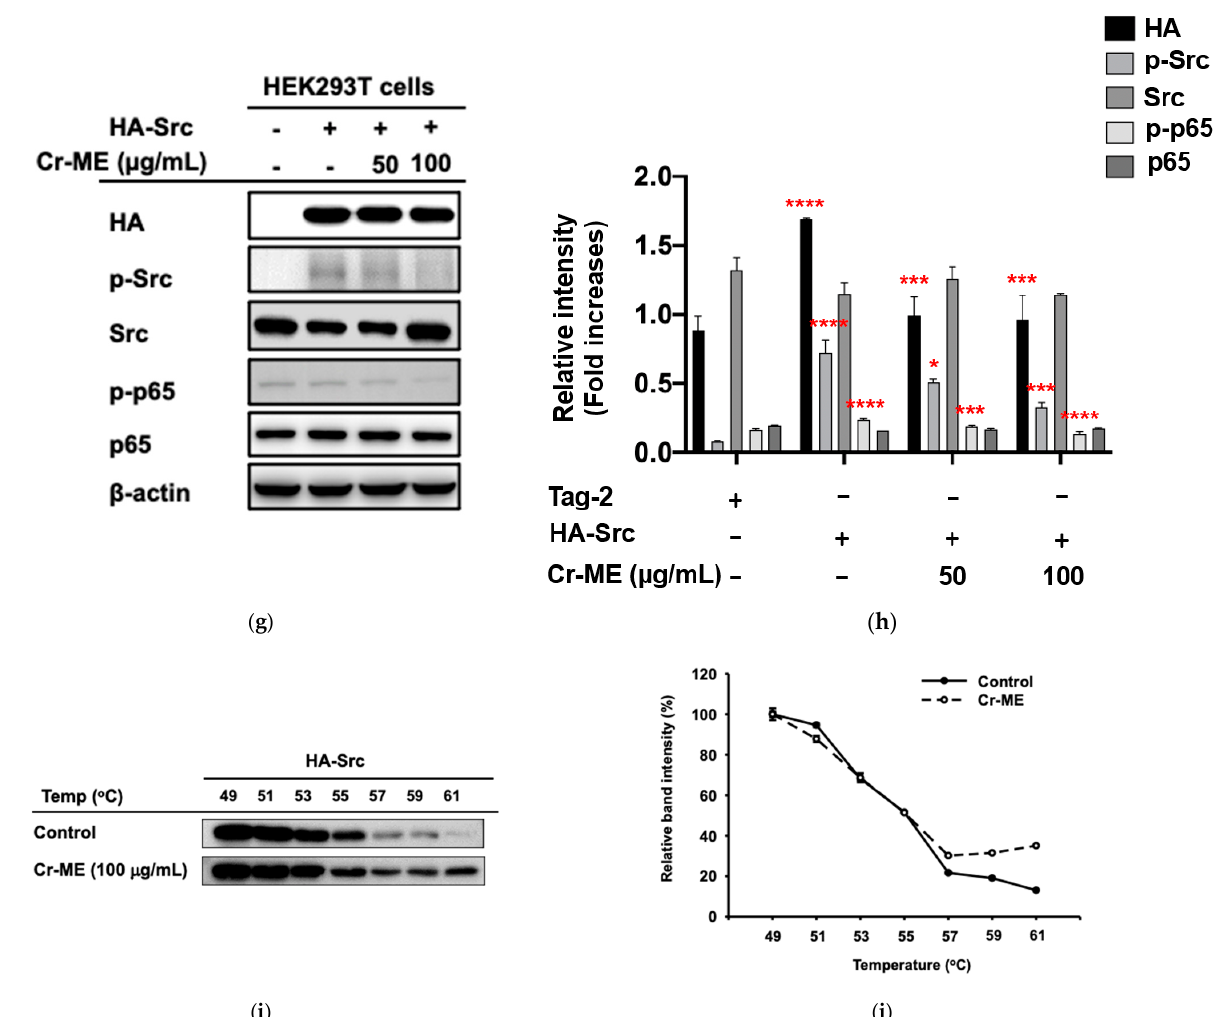
Figure 3. Effect of Cr-ME on NF- κ B pathway and its upstream enzyme Src activation. ( a , b ) The levels of phospho- forms of NF- κ B subunits (p-p65 and p-p50) and their total proteins were determined by Western blotting analysis with whole cell lysates of RAW264.7 cells treated with LPS (1 μ g/mL) in the presence or absence of Cs-ME (100 μ g/mL) for the indicated times ( a ). Relative intensity of these proteins was calculated by ImageJ ( b ). ( c , d ). The levels of phospho-forms of I κ B α and IKK α / β and their total proteins were determined by Western blotting analysis with whole cell lysates of RAW264.7 cells treated with LPS (1 μ g/mL) in the presence or absence of Cs-ME (100 μ g/mL) for the indicated times ( c ). Relative intensity of these proteins was calculated by ImageJ ( d ). ( e , f ) The levels of phospho-forms of Src and Syk and their total proteins were determined by Western blotting analysis with whole cell lysates of RAW264.7 cells treated with LPS (1 μ g/mL) in the presence or absence of Cs-ME (100 μ g/mL) for the indicated times ( e ). Relative intensity of these proteins was calculated by ImageJ ( f ). (g and h) The levels of phospho-forms of Src and p65 and their total proteins were determined by Western blotting analysis with whole cell lysates of HEK293T cells were transfected HA-Src in the presence or absence of Cs-ME (100 μ g/mL) for 24 h ( g ). Relative intensity of these proteins was calculated by ImageJ ( h ). ( i , j ) The CETSA assay was conducted in the HA-Src-transfected HEK293T cells treated with Cr-ME (100 μ g/mL) or DMSO (as a control) and then, Src level was determined by Western blotting analysis ( i ). Relative intensity of Src was calculated by ImageJ ( j ). All the data ( b , d , f , h , j ) expressed as the mean ± SD of three independent experiments. Statistical significance was calculated using one-way ANOVA (Dunnett’s t -test). # p < 0.05, ## p < 0.01, ### p < 0.001, and #### p < 0.0001 compared to normal group, and * p < 0.05, ** p < 0.01, *** p < 0.001, and **** p < 0.0001 compared to the control group.